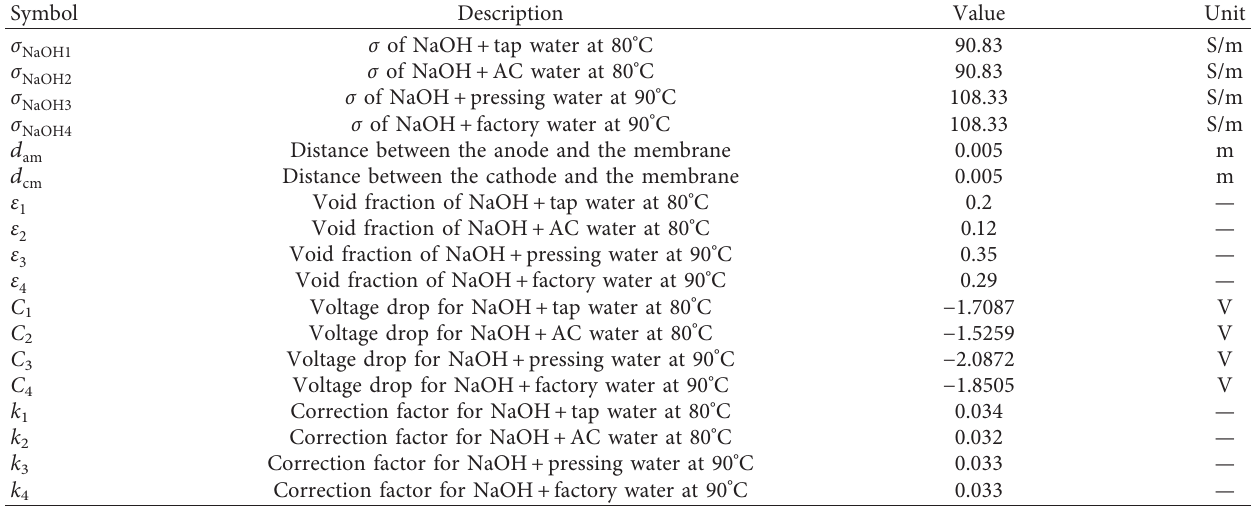
Table 7: Parameters specific to the experiment on the types of electrolyte at 40wt%.